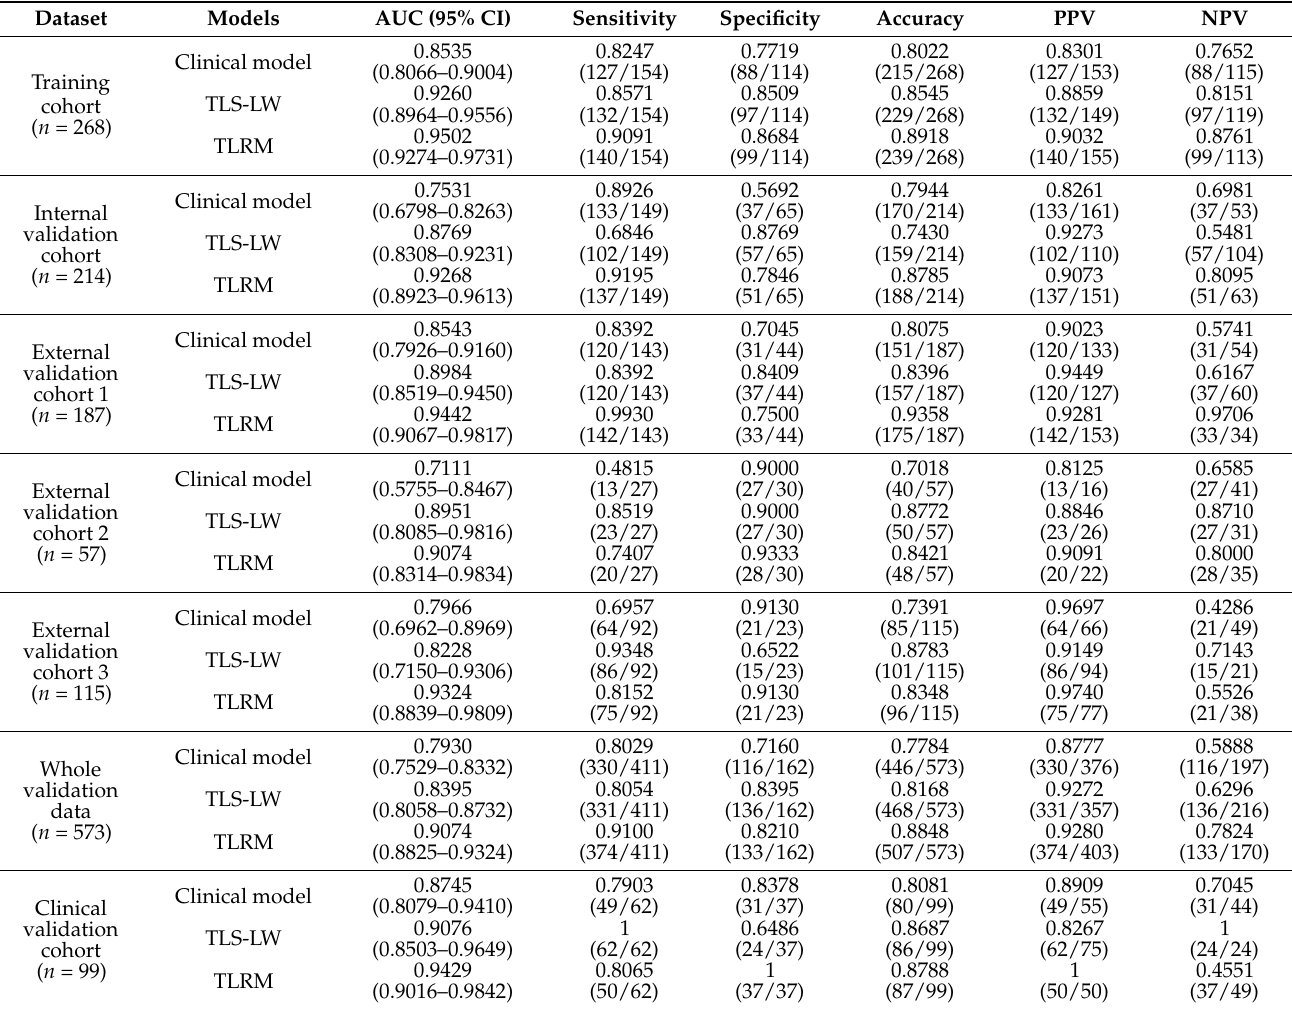
Table 4. Performance of the clinical model, TLS-LW, and TLRM for the LAC and LGN groups among patients with SPSNs in the training cohort, four validation cohorts and whole validation